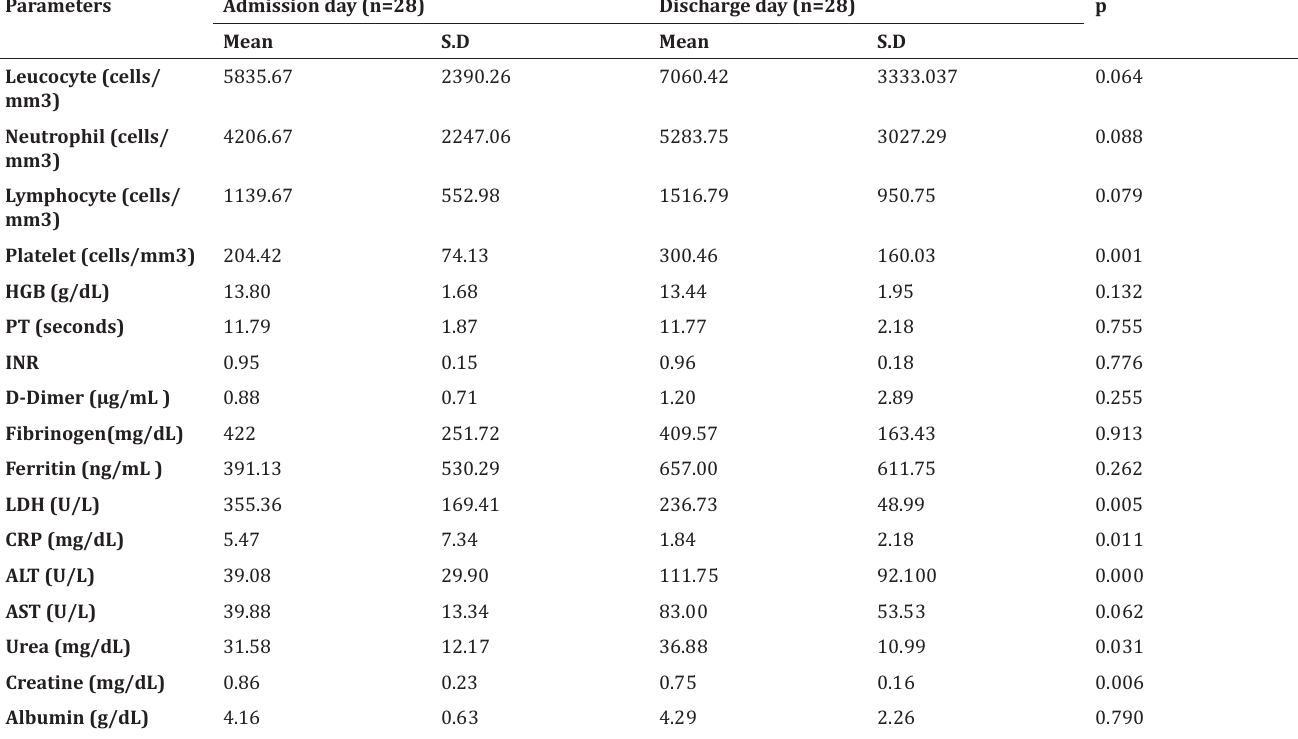
Laboratory parameters of COVID-19 infected inpatients at admission day and discharge day Parameters Admission day (n=28)